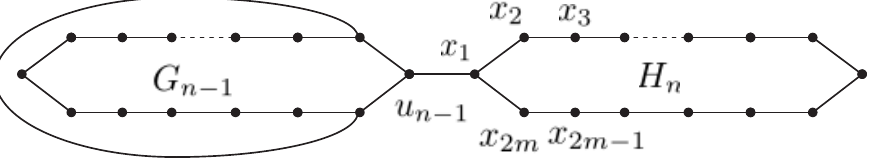
Figure 1. A polygonal chain G n with n polygons.